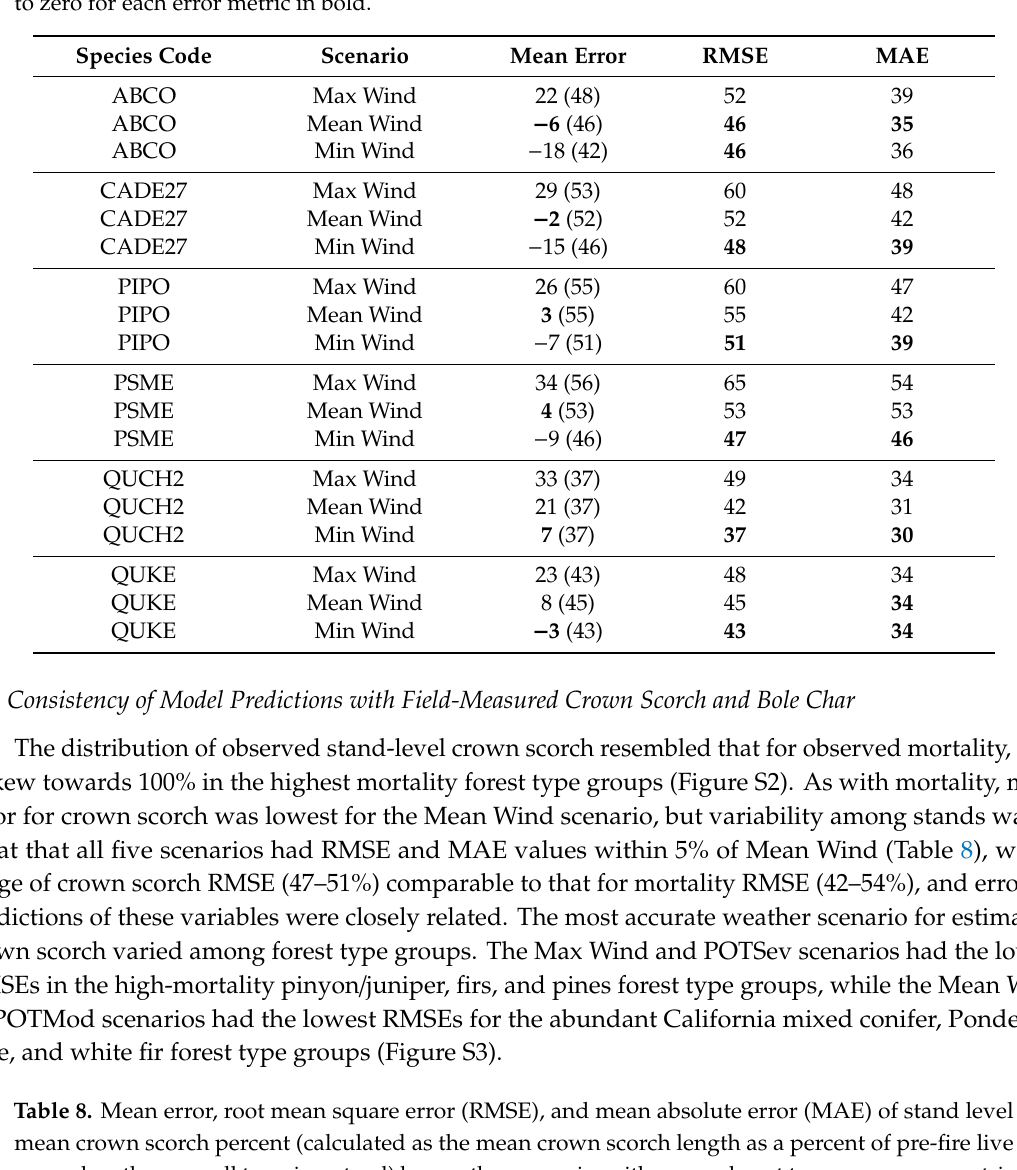
Table 7. Mean error (with standard deviation in parentheses), root mean square error (RMSE), and mean absolute error (MAE) of fire-induced mortality as a percent of pre-fire, live tree basal area di ff erences (observed minus predicted) for common ( n > 500 trees) species by weather scenario, with errors closest to zero for each error metric in bold.